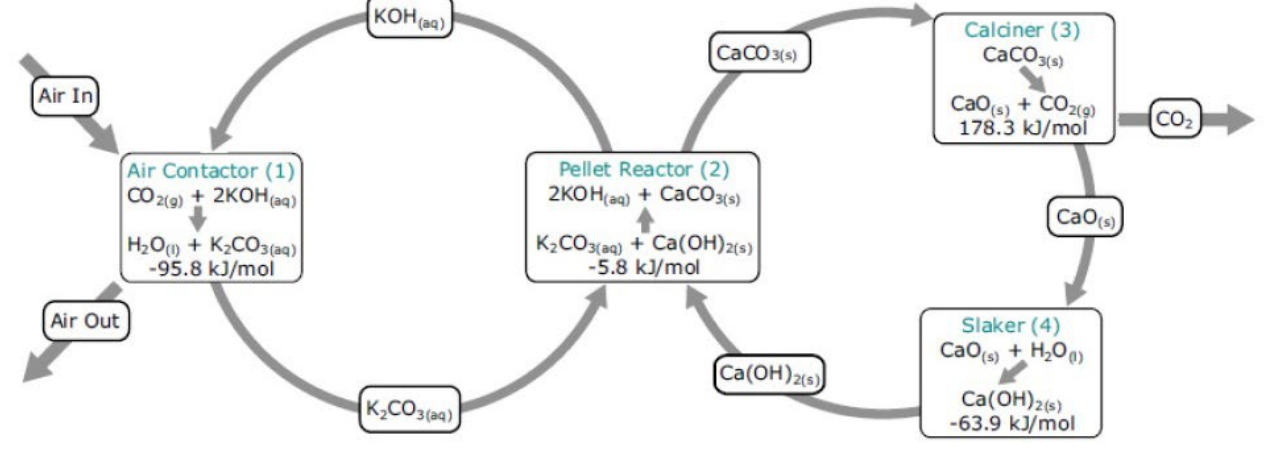
Figure 4 . Scheme of the process analyzed by Keith et al. [34] using a KOH solution. Reproduced Figure 4. Scheme of the process analyzed by Keith et al. [34] using a KOH solution.